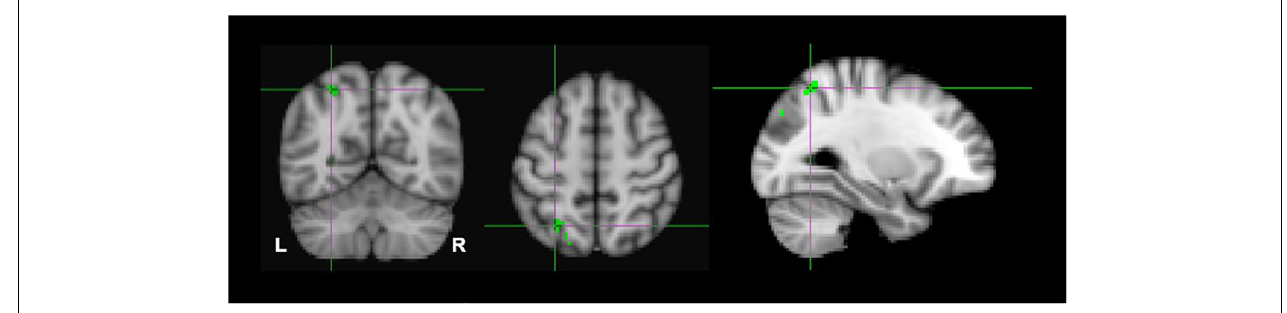
FIGURE 8 | Group results for monocular stereopsis, revealed by the fixed-effects ( N = 7) GLM contrast [MaP INTACT > MaP SCRAMB ] > [BP INTACT > BP SCRAMB ]. All responses are masked to gray matter. FDR ( p < 0.05) corrected p < 0.001. The crosshairs represent the peak in the left parietal cortex [MNI coordinates: − 28, − 60, and